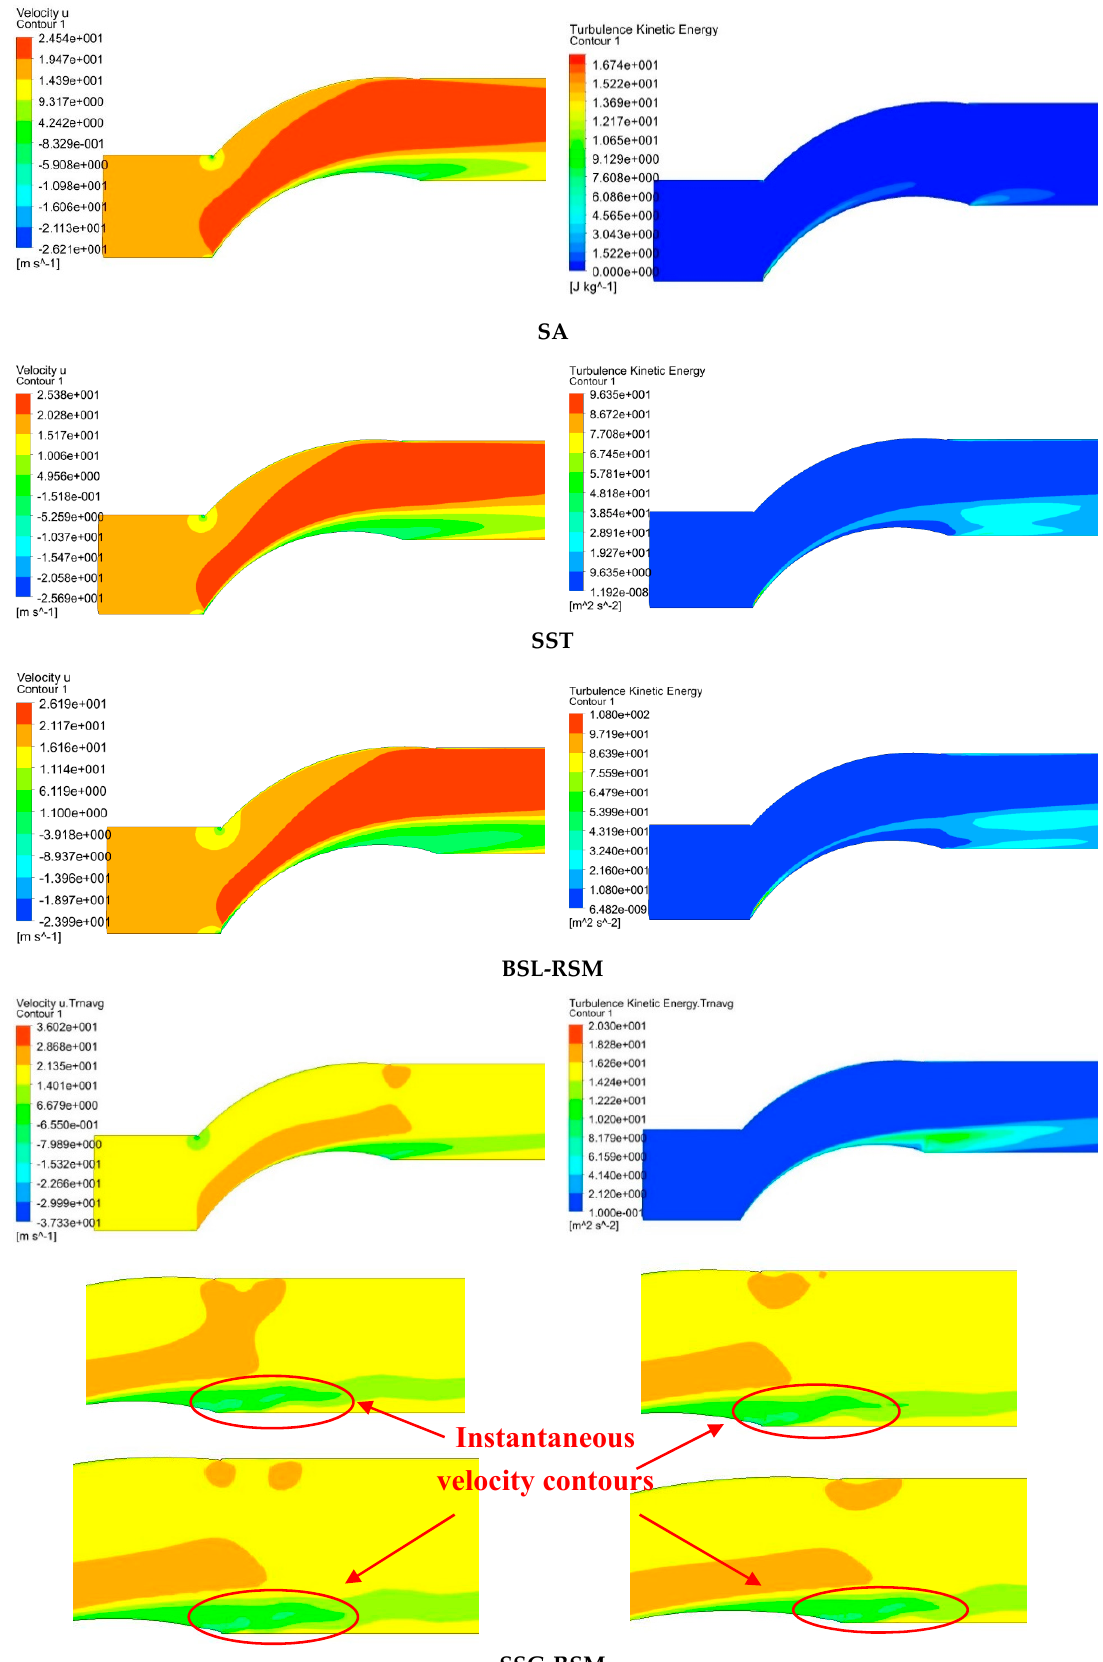
( b ) Figure 11. Instantaneous velocities in the wake region ( a ) and Fourier transform of the unsteady velocity motion inside the compressor blade wake ( b ) for the SSG-RSM. From the analysis, a dominant frequency of 250 Hz was identified, which is the frequency that characterizes the unsteady trailing edge large scales that were computed with URANS and the SSG- RSM. By observing both the measured and the computed turbulence intensity values it is evident that in order to accurately compute such complex flows and be able to capture the unsteady kinetic energy of the flow with the turbulence modelling methodology, the use of less dissipative turbulence models that will accurately model the turbulence transitional characteristics and itsgeneration due to free shear and also compute/resolve the strong unsteady nature of the flow is obligatory. As it was presented in [11,25], more sophisticated turbulence models (i.e., a cubic eddy viscosity model and a non-linear RSM) were able to provide qualitative results for capturing the wake development of a